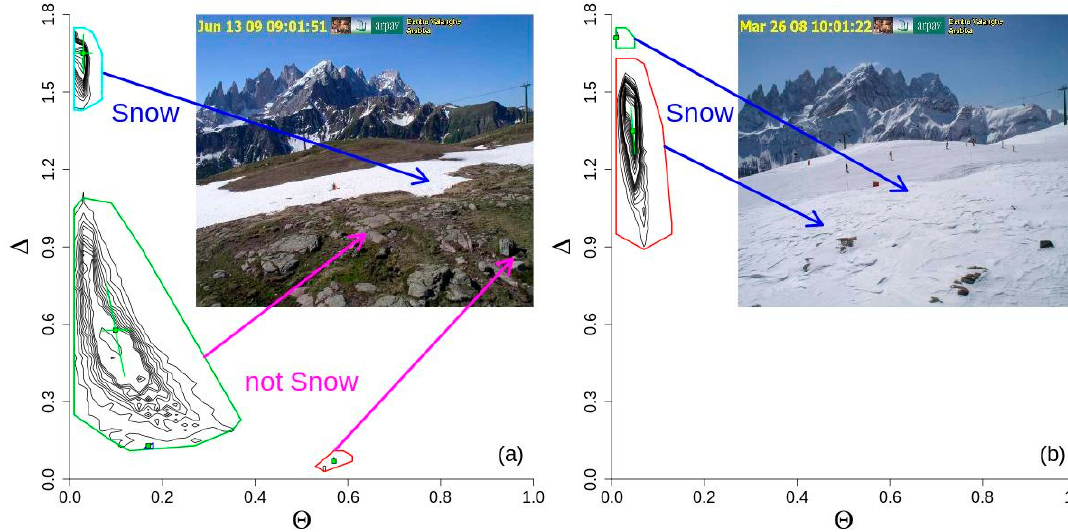
Figure 3. Examples of two different snow-not-snow mixtures. Colored polygons identified areas of clusters in presence of two different situations: partial ( a ) and full ( b ) snow cover. Lower plots are frequency distribution of pixels at the different spectral angles ( 𝜃 ) and spectral distances ( 𝛥 ).